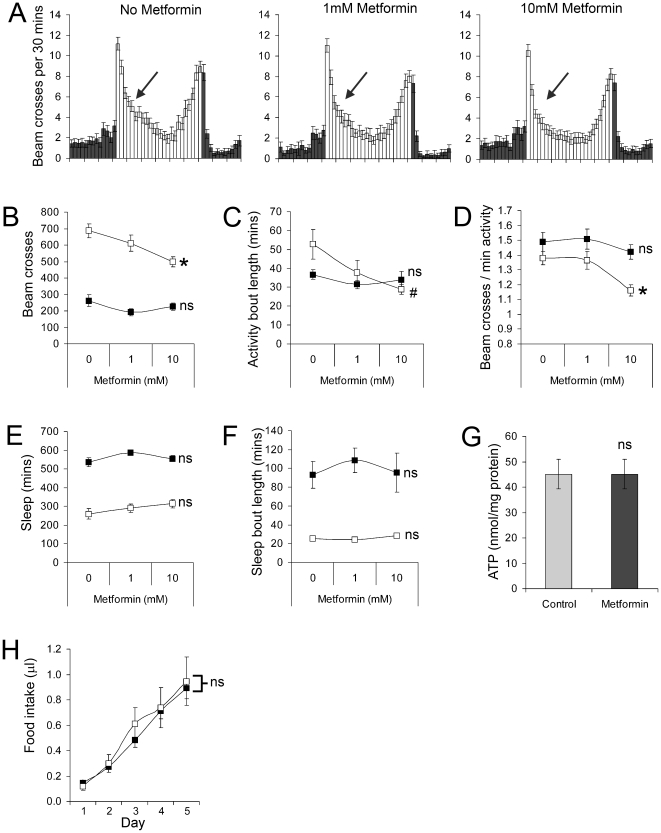
The effect of Metformin on sleep-wake behaviour, basal ATP and food intake.(A) Flies were provided with agar based diet containing 30% sucrose, supplemented with Metformin at the stated dose. The three charts show mean (±SEM) beam crosses from three days of behavioural monitoring. The arrows are identically placed within each chart and point to the decrease in morning activity. (B) Locomotor activity (beam crosses) on diets containing difference concentrations of Metformin. (C) Length of each activity bout. (D) Intensity of locomotor activity. (E) Total amount of sleep. (F) Length of each sleep bout. (G) Basal ATP in flies. (H) Food intake by flies on control (filled boxes) or 10 mM Metformin (open boxes), as measured by CAFE assay. In B–F open and filled boxes relate to data collected during the day and night of the 12 hr∶12 hr light-dark cycle, respectively. Data are expressed as the mean (±SEM) and is pooled from two impendent trials using a total of 32 flies for each treatment. *P<0.01, # = P<0.05, ns  =  not significant.